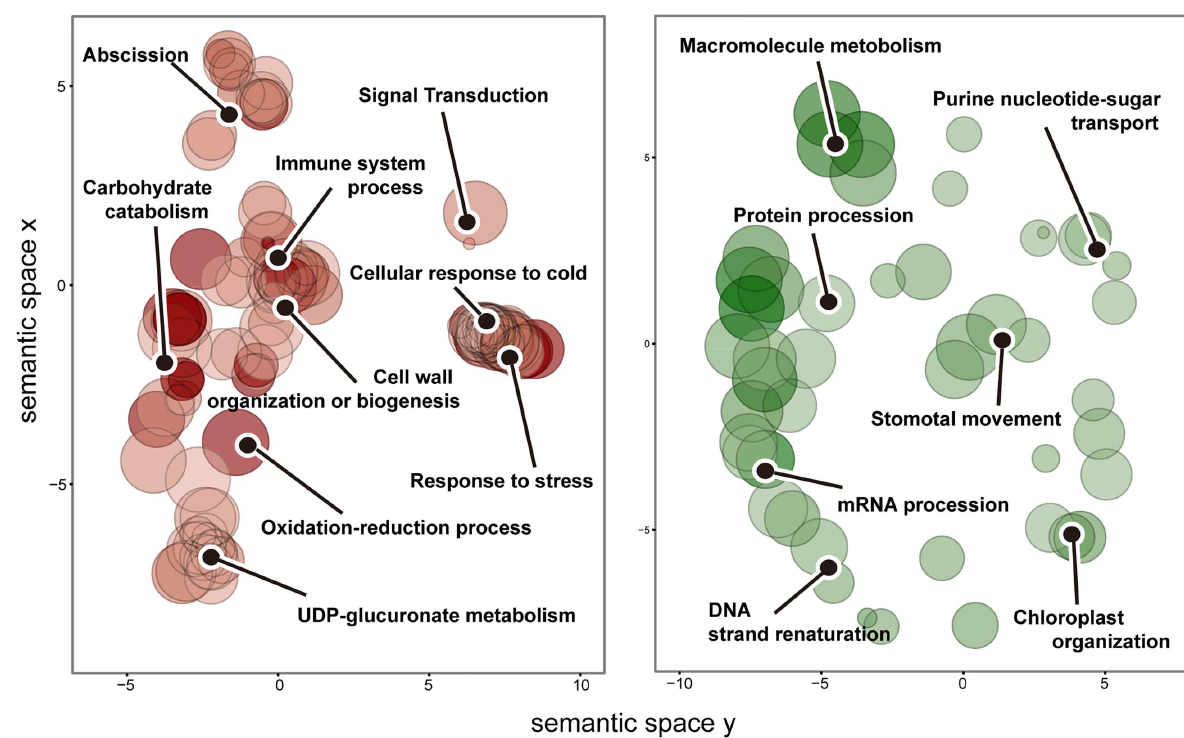
Fig 3. Significantly enriched GO terms in biological process category in a two-dimensional semantic space. Red-filledcircles represent enriched GO terms of up-regulated CORs, and green-filledcircles represent enrichedGO terms of down-regulated CORs. Color intensity reflects the significance of enrichmenttest, with dark colors corresponding to lower P values and all P values lower than 0.05. Circle radiuses depict the sizes of the aggregatedGO